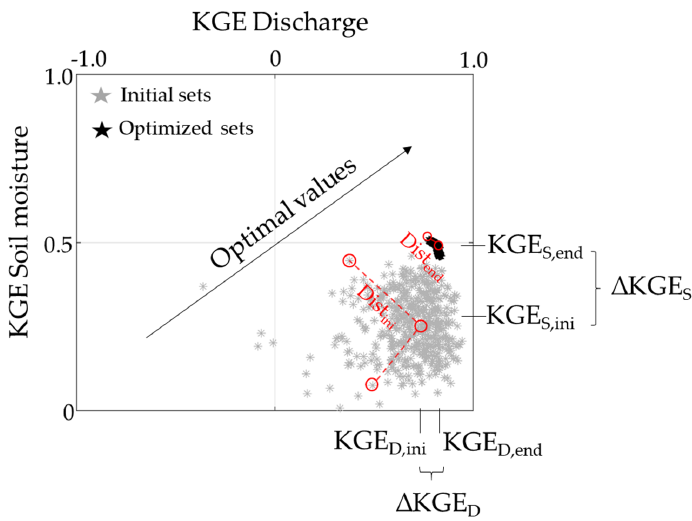
Figure 3. Illustrative scatterplot of initial and optimized sets of KGE values for a hypothetical gauge, explaining the accuracy ( ∆ KGE D and ∆ KGE S ) and precision ( Dist (cid:2919)(cid:2924)(cid:2919) / Dist (cid:2915)(cid:2924)(cid:2914) ) improvement metrics. The initial and optimized sets contain 500 individuals